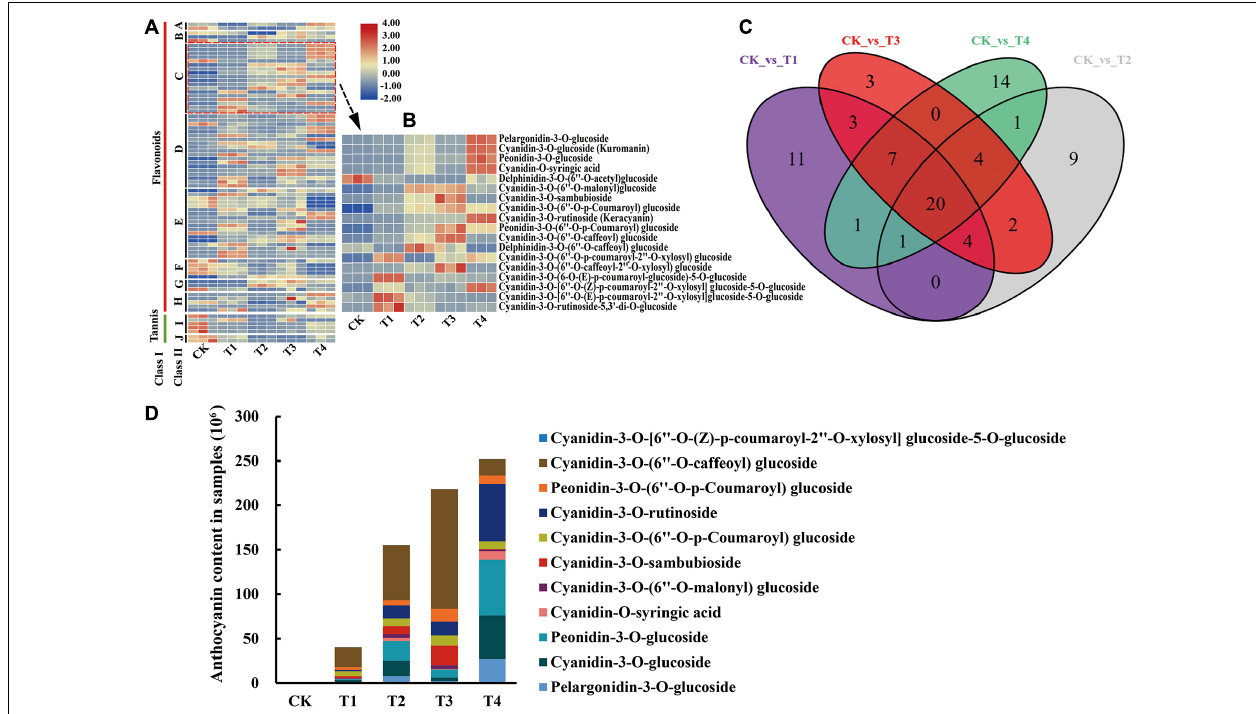
FIGURE 2 | Differentially accumulated metabolites analysis of metabolome. (A) The heatmap analysis of all differentially accumulated metabolites by TBtools. A, chalcones; B, dihydroflavonol; C, anthocyanins; D, flavonoid; E, flavonols; F, flavonoid carbonoside; G, flavanols; H, isoflavones; I, tannin; J, proanthocyanidins. (B) The heatmap analysis of all DAAs according to the relative content in samples. (C) Venn analysis among CK vs T1, CK vs T2, CK vs T3, and CK vs T4. (D) The relative content of overlapping DAAs (11 anthocyanins) in five C. japonica cultivar petals.